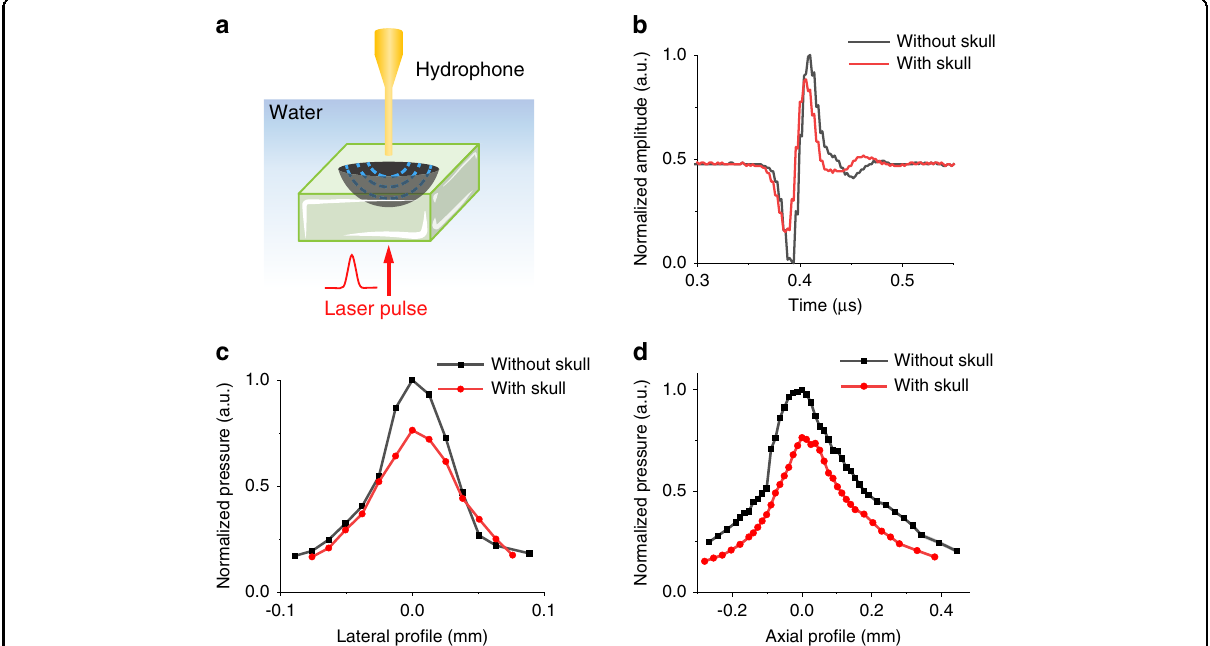
Fig. 2 Transcranial ef fi ciency and high spatial resolution of OFUS penetrating a mouse skull. a The illustration of the experimental setup for characterizing OFUS with a needle hydrophone. b Time domain optoacoustic signals were measured at the focus without and with a piece of mouse skull. Results were normalized to the peak pressure without the skull. c The lateral resolution of OFUS without and with a piece of mouse skull. d The axial resolution of OFUS without and with a piece of mouse